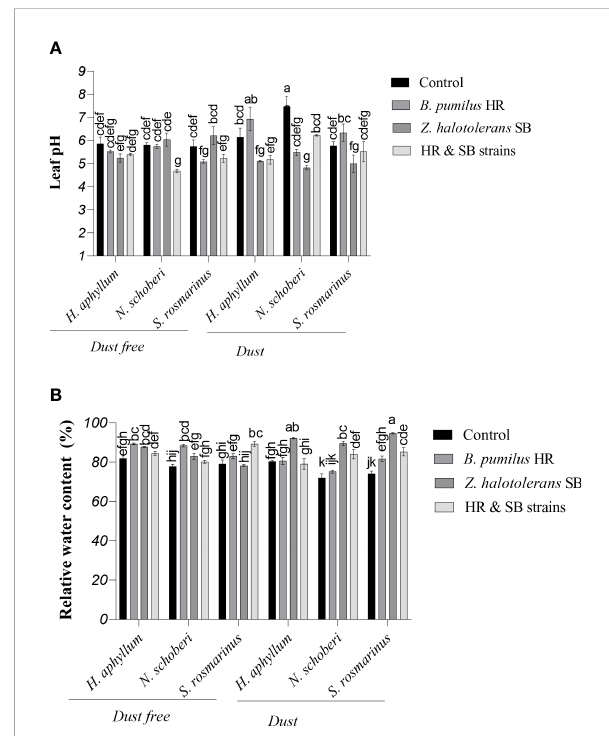
FIGURE 2 Triple interactions of treatments of bacterial strains, three desert plant species of S. rosmarinus , H. aphyllum and N. schoberi and dust on leaf pH (A) and relative water content (B) of the leaves of three plant species grown under greenhouse conditions for fi ve months. Alphabets indicate signi fi cant differences among various treatments (Means ± SE, n = 3) according to Tukey ’ s multiple-range test at p